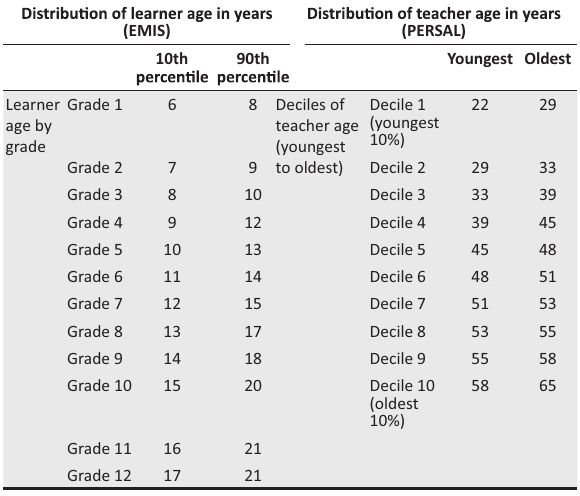
FIGURE 3: The distribution of learner age range (10th–90th percentile) by grade, and teacher age by decile in South Africa.